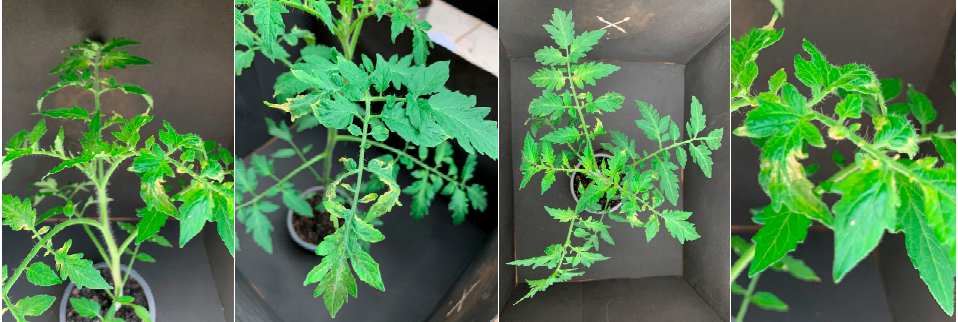
Figure 19. The effects of simulated isoxaflutole drift with a close-up view show injuries in tomato plants.